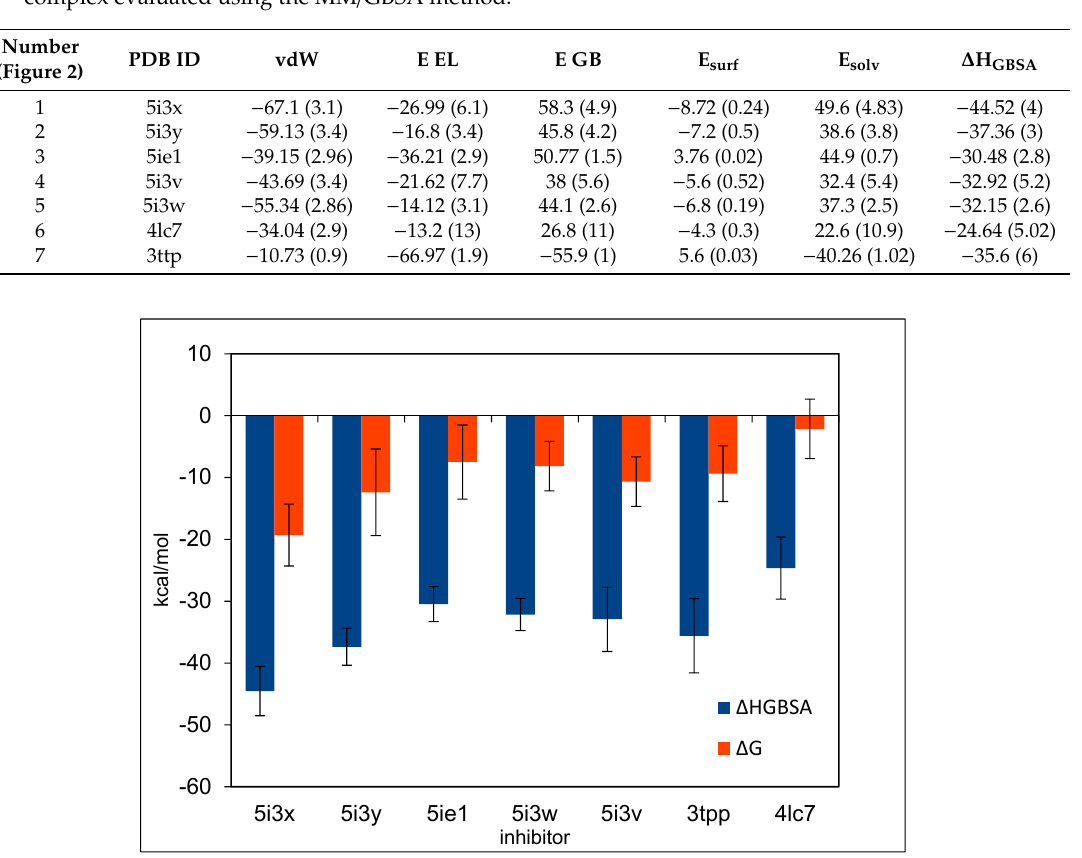
Table 2. The di ff erent components of binding free energy (kcal / mol) between the inhibitors-BACE1 complex evaluated using the MM / GBSA method.